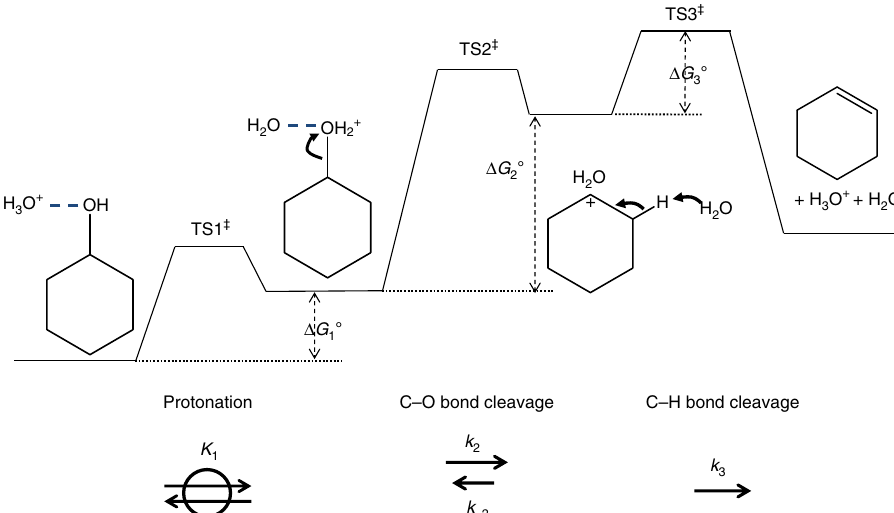
Figure 3 | Schematic representation of free energy profile for aqueous-phase cyclohexanol dehydration via an E1 elimination pathway. The reactions are catalysed by hydrated hydronium ions, abbreviated as H 3 O þ , either in solution or in pores. In aqueous solutions, H 2 O is the most abundant species to deprotonate the carbenium ion. Under our reaction conditions, protonation is quasi-equilibrated, C–O bond cleavage is reversible, and C–H bond cleavage is irreversible. In this work, k -2 was never much smaller than k 3 . For a boundary situation where k 3 is much smaller than k -2 , the measured free energy would be the sum of D G 1 (cid:2) , D G 2 (cid:2) and D G 3 (cid:2) Table 3 | Intrinsic activation parameters for aqueous-phase dehydration of cyclohexanol.* Catalyst